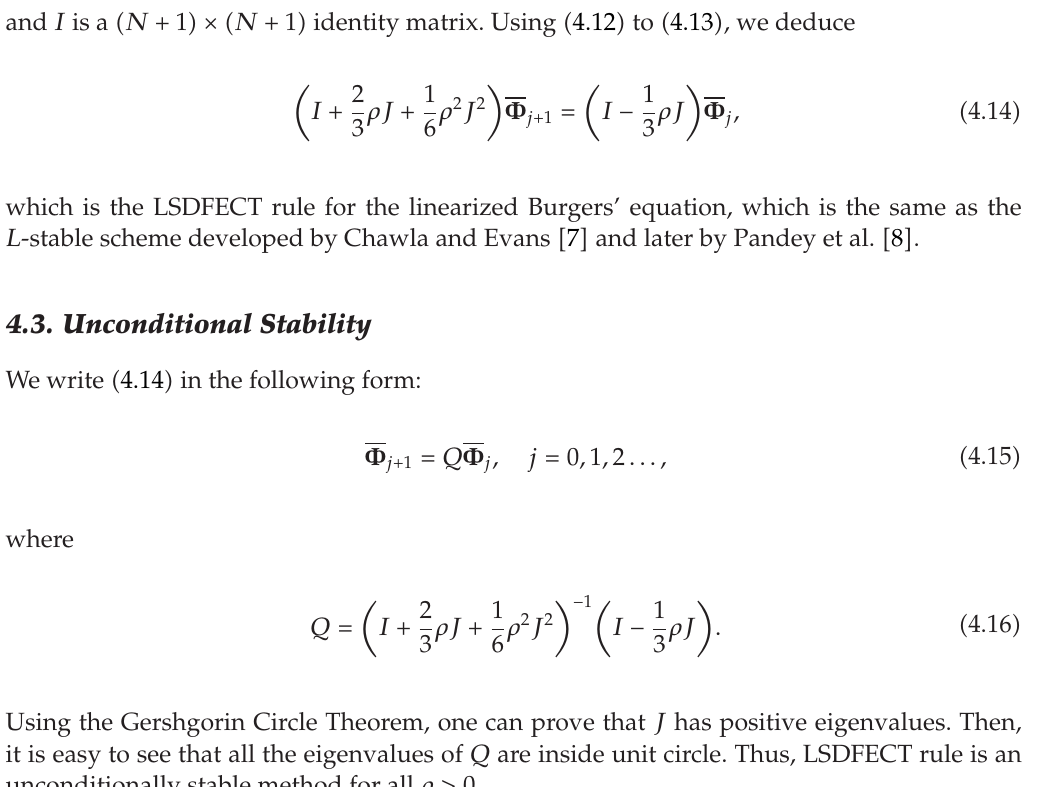
and I is a (cid:2) N (cid:9) 1 (cid:3) × (cid:2) N (cid:9) 1 (cid:3) identity matrix. Using (cid:2) 4.12 (cid:3) to (cid:2) 4.13 (cid:3) , we